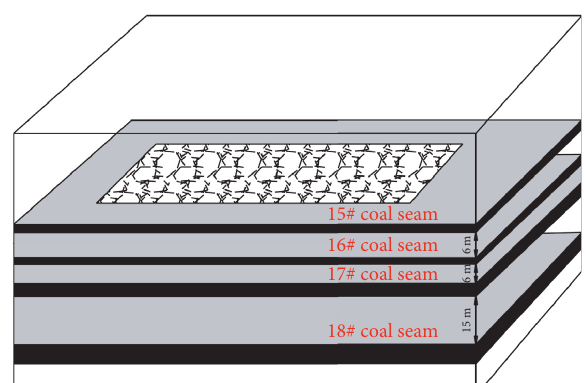
Figure 2: Schematic diagram of the spatial position relationship of coal